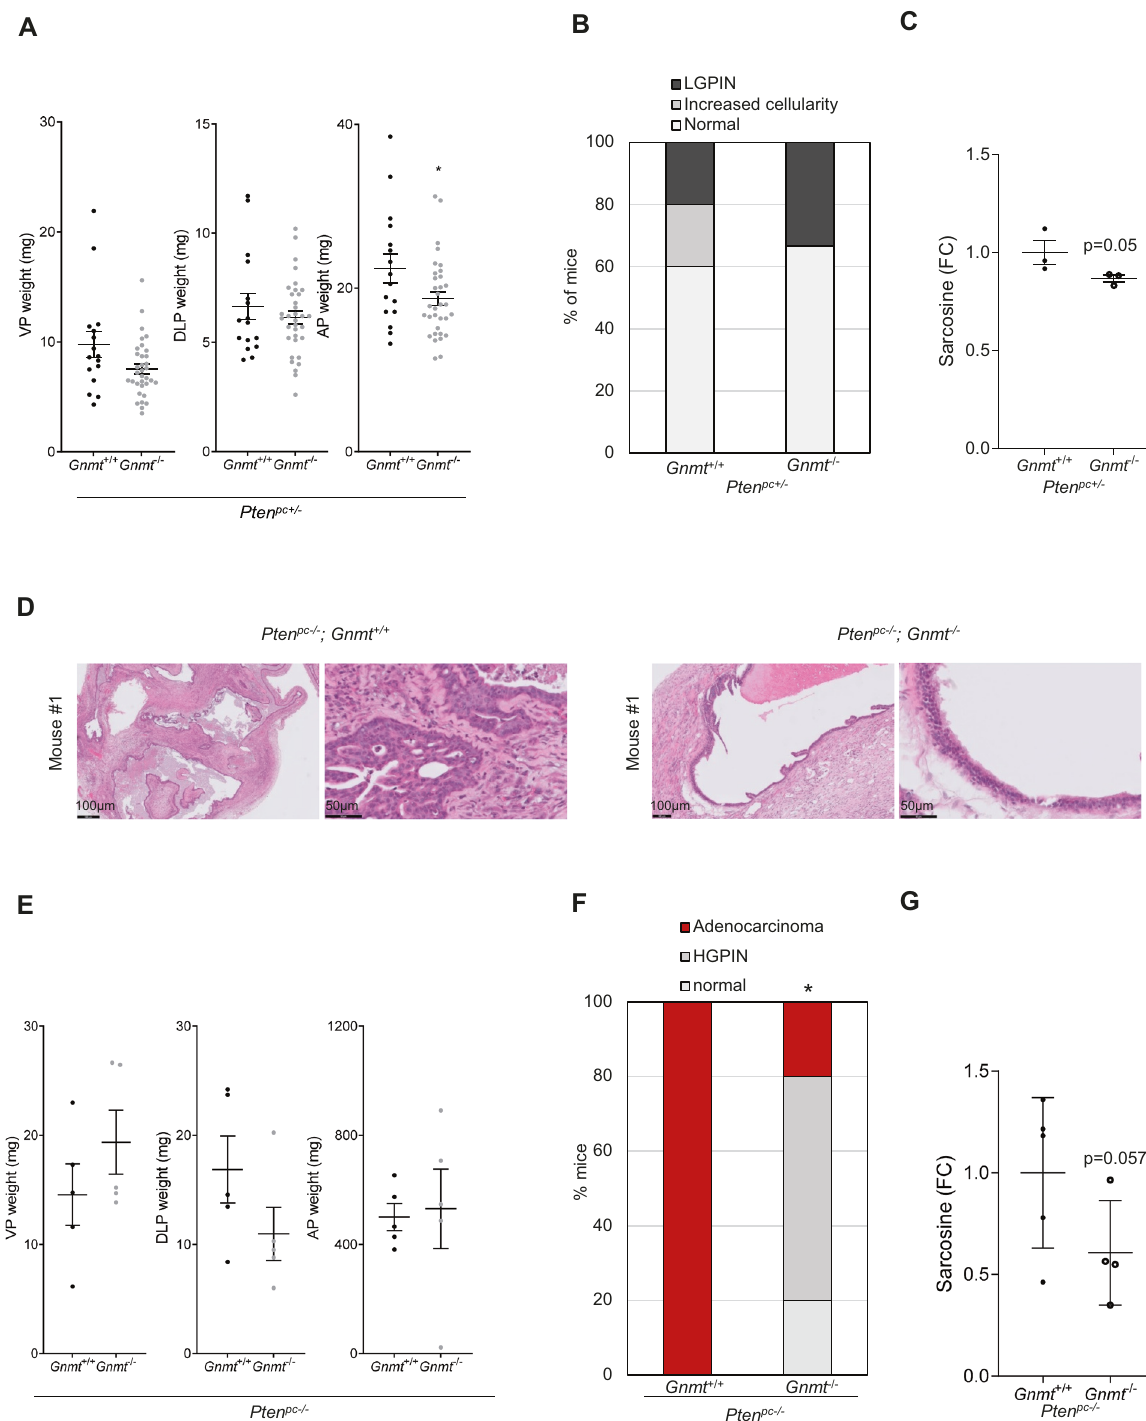
Fig. 3 Gnmt is required for prostate cancer development. A – C Prostate lobe weights (VP, DLP, and AP) in Pten pc + / − ; Gnmt + / + and Pten pc + / − ; Gnmt − / − mice (2 individual lobes are presented per mouse, n = 8 – 16) ( A ); Histopathological characterization of the prostate tissue in Pten pc + / − ; Gnmt + / + and Pten pc + / − ; Gnmt − / − mice ( n = 8 – 16) ( B ); Sarcosine abundance in anterior prostate (AP) lobes in the indicated genotypes measured by LC/MS ( n = 3) ( C ). D – G Representative histological images of Hematoxylin Eosin (H&E) staining (100X and 400X) in Pten pc − / − ; Gnmt + / + and Pten pc − / − ; Gnmt − / − mouse prostates ( D ); Comparison of different prostate lobe weights (VP, DLP, and AP) (represented in the graph with 2 different individual lobes) ( n = 4 – 5) Pten pc − / − ; Gnmt + / + and Pten pc − / − ; Gnmt − / − mice ( E ); Histopathological characterization of the prostate tissue ( n = 5) ( F ) and Sarcosine amount in anterior prostate (AP) lobes measured by LC/MS ( n = 4 – 5) ( G ) in Pten pc − / − ; Gnmt + / + and Pten pc − / − ; Gnmt − / − mice ( n = 5). VP Ventral prostate, DLP Dorsolateral prostate, AP Anterior prostate, LGPIN Low-grade Prostatic Intraepithelial Neoplasia, HGPIN High grade Prostatic Intraepithelial Neoplasia. Statistics: One tail Mann-Whitney U test ( A left and middle panels, C , E , G ), Two tailed Student T test (right panel), and Chi square ( F ) was used for data analysis. p , p value; * p <